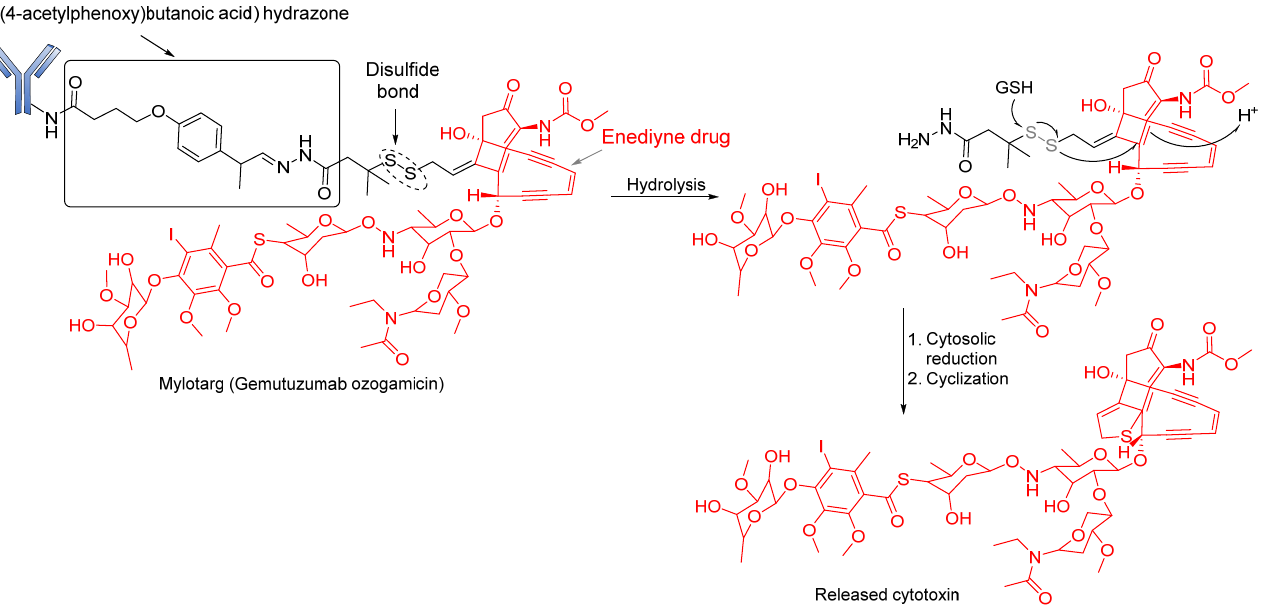
Figure 5. Cleavage mode of hydrazone linker in Mylotarg. Under strong acidic conditions, the metabolite—calicheamicin—is released first by hydrolysis of the hydrazone moiety, followed by the cytosolic reduction of the disulfide bond to afford the free sulfide anion. This then forms a thiophen ring through cyclization.